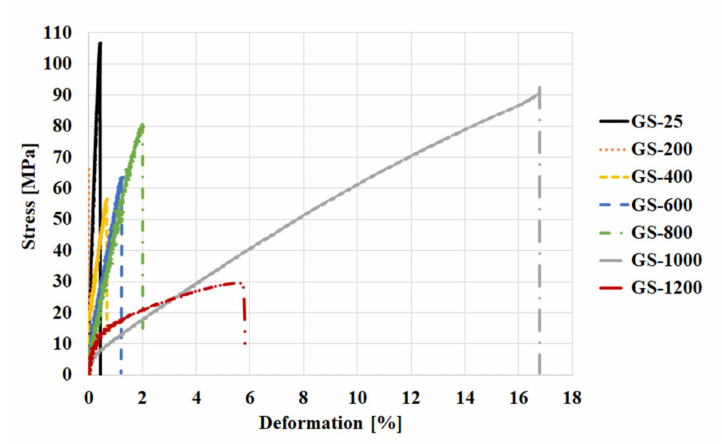
Figure 9. In situ compression test stress–deformation curves at di ff erent temperatures for chamotte geopolymer